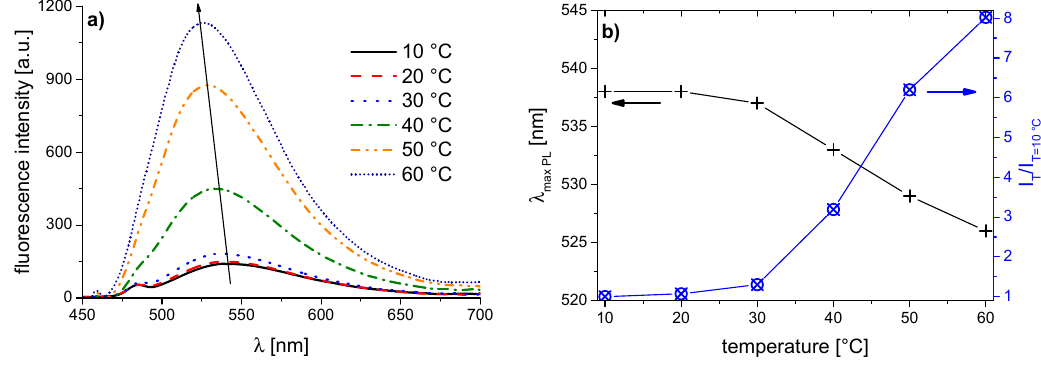
Figure 9. Temperature dependent fluorescence behavior of PNVCL-e in aqueous solution (concentration 0.10 g·L − 1 ):( a ) normalized emission spectra ( λ Exc = 416 nm); and ( b ) evolution of λ maxEm of the emission band, and of the fluorescence intensity normalized to 10 °C.